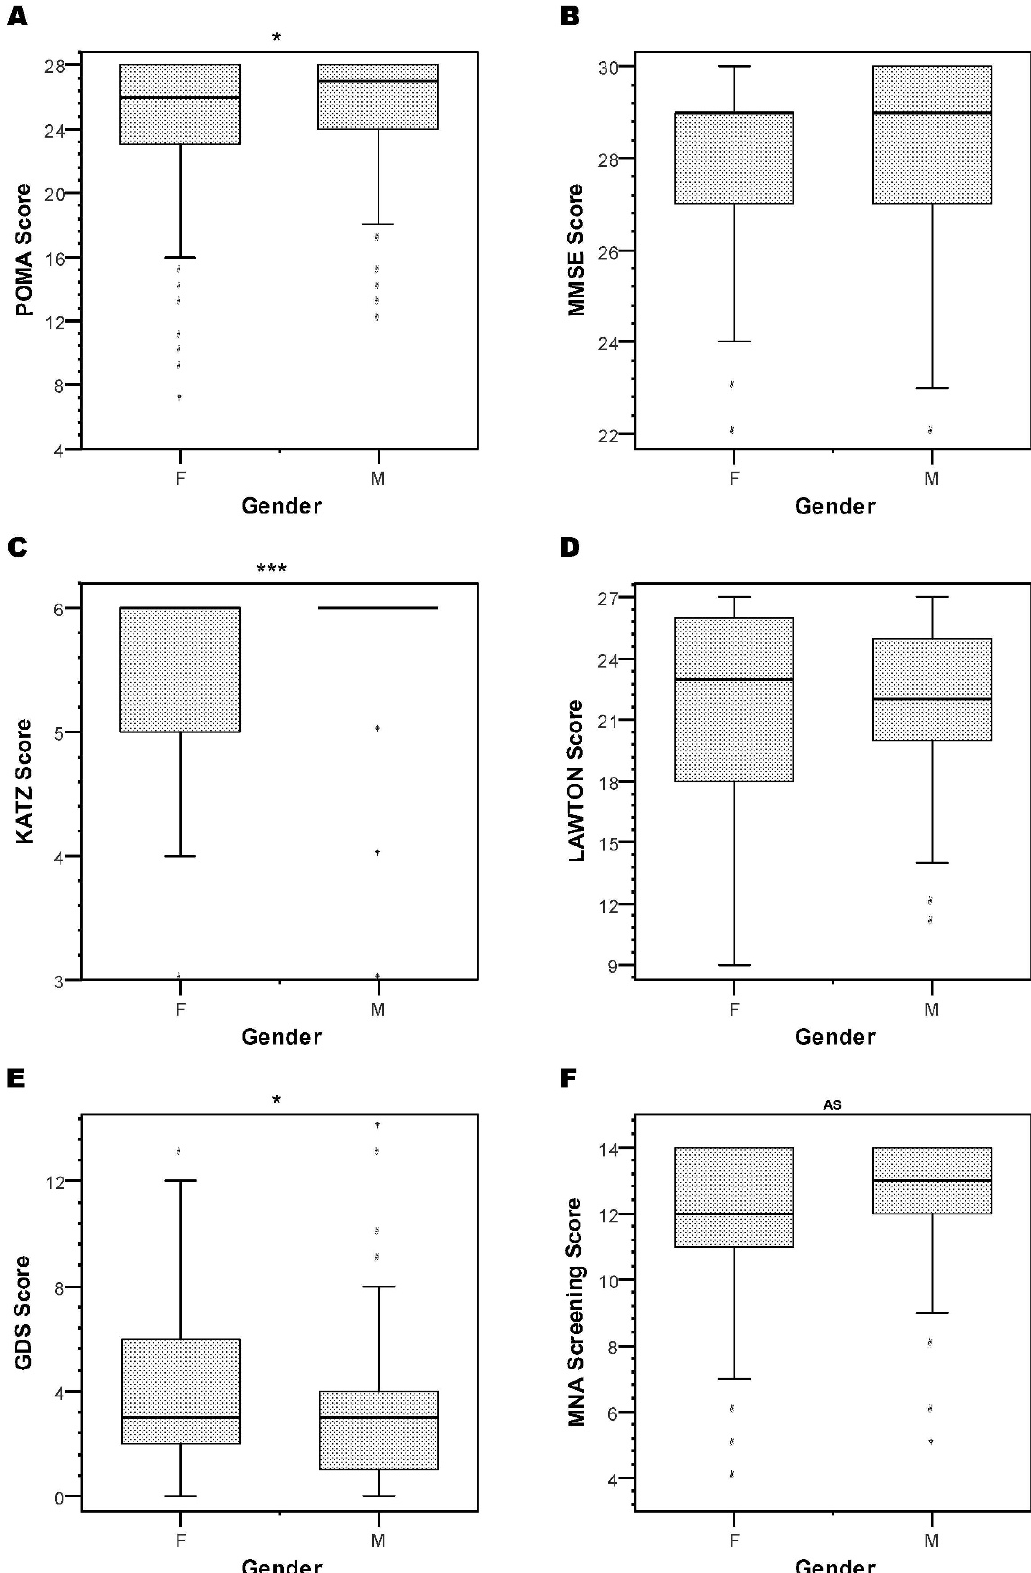
Functional alterations in the elderly Teixeira-Leite H and Manha˜es